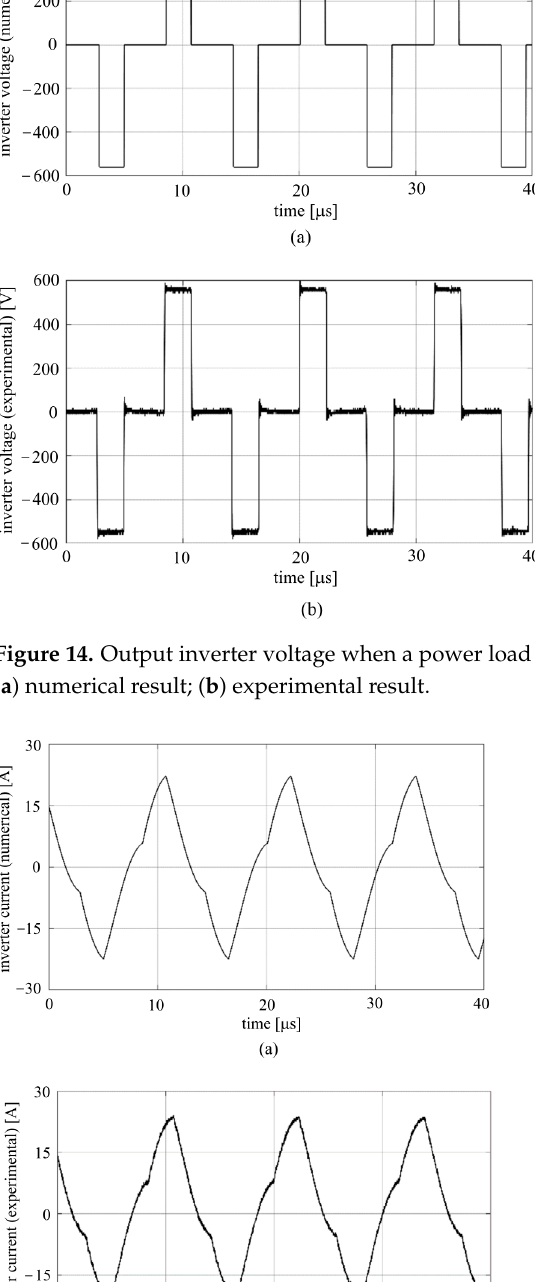
Figure 16. Measured output secondary rectifier power in nominal conditions. The surges in the waveform of the power from the secondary rectifier are caused by the switch ringing and are more evident in correspondence to the instants when the conduction of the MOSFETS begin.